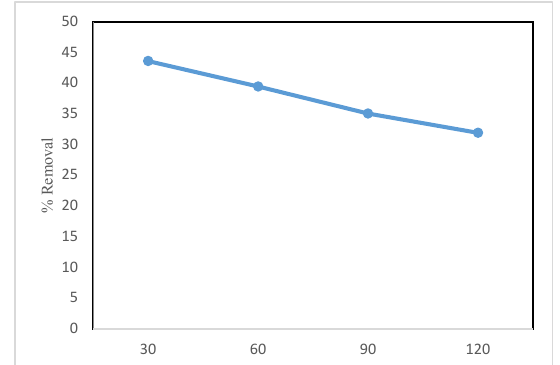
Fig. 2. The removal efficiency of Ni(II) by ferrous sulfate at different contact times (30,60,90, and 120 min)